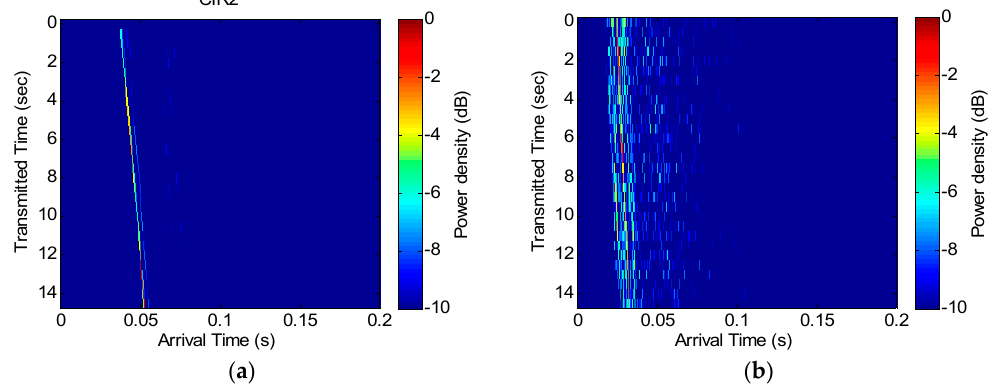
Figure 13. Measured channel impulse responses for ( a ) the first lake trial and ( b ) the second lake trial.